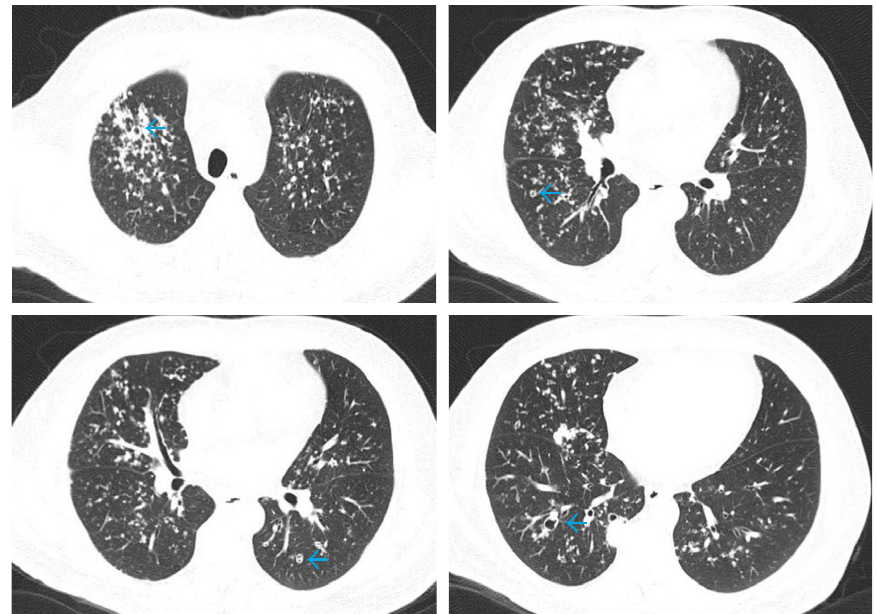
Figure 3: Selected images of computed tomography (CT) scan of the chest on admission to our hospital. Axial images in lung window confirm diffuse micronodules with central cavitation of varying sizes (blue